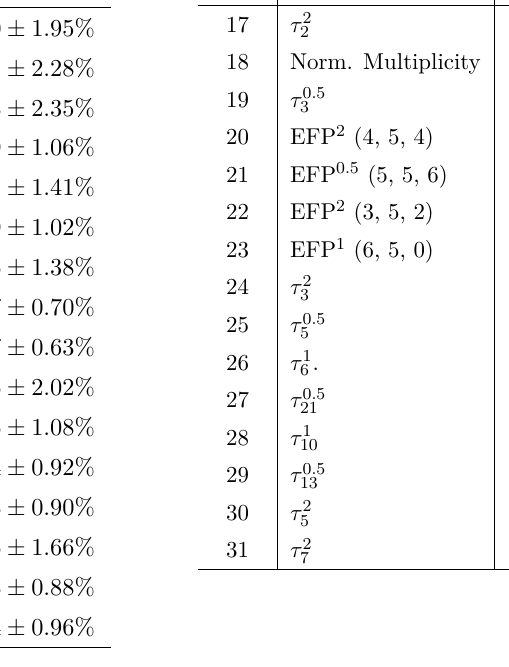
Table 2 . Ranking of the 31 LASSO-selected observables in order of importance, with the most important corresponding to the largest drop in accuracy of the model. The corresponding distribu- tions and EFP graphs are displayed in figures 11 and